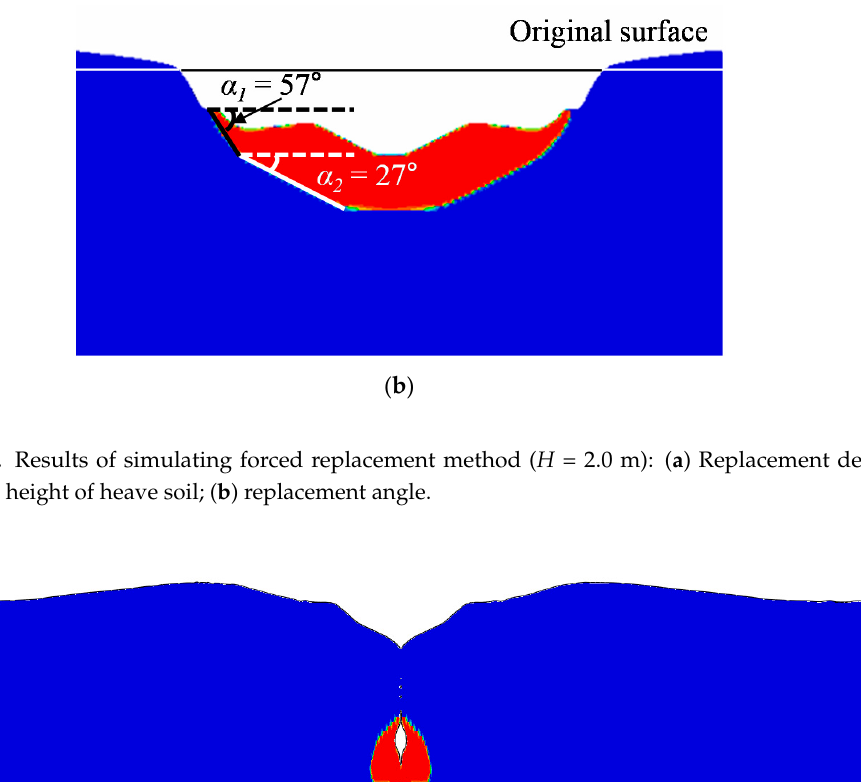
Figure 11. Results of simulating forced replacement method ( H = 3.0 m).